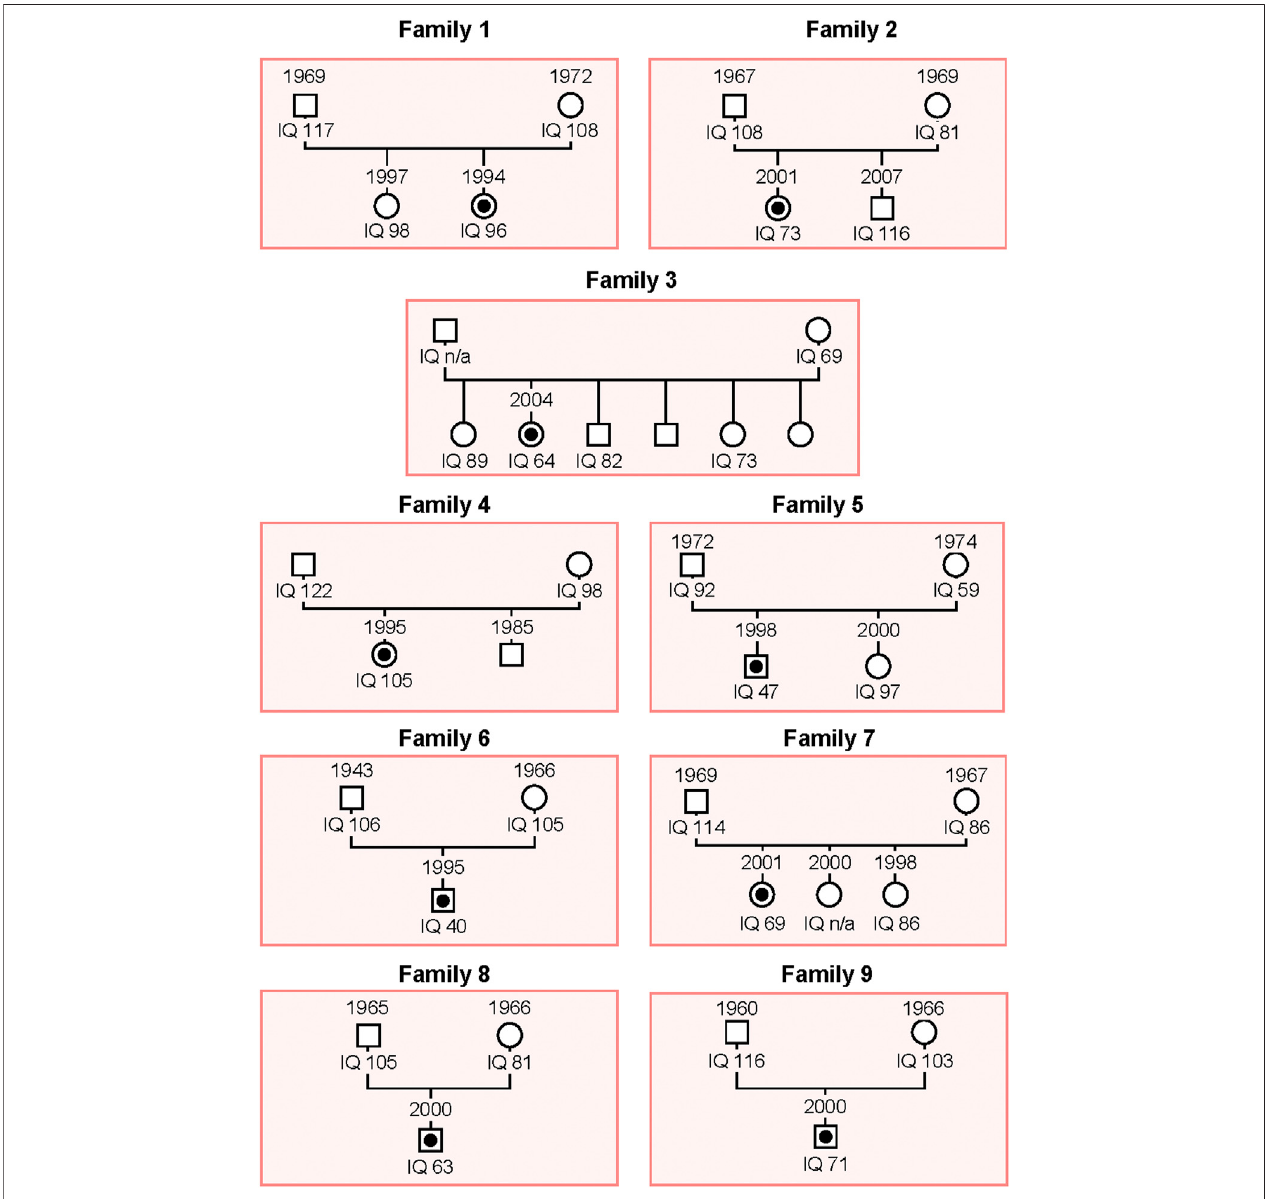
FIGURE 1 | Schema of the genealogical trees of Families 1 – 9. The proband of each family is indicated with a black dot. Squares: men; circles: women.